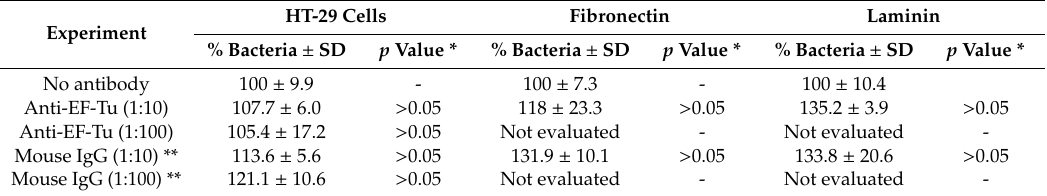
Table 3. Adherence of the EDL933 strain to HT-29 cells, fibronectin, and laminin in the presence of a monoclonal anti-EF-Tu antibody (mAb 900).